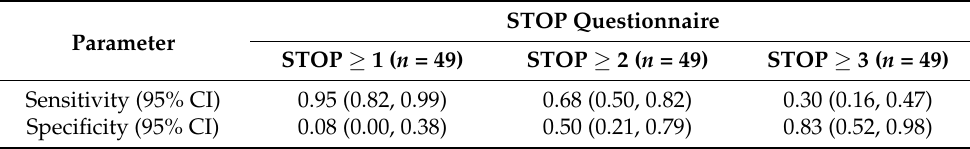
Figure 1. Questionnaire ROC Curve Analysis. Receiver operating characteristic curve for questionnaires constructed from the data presented in Tables 2 and 3. Abbreviations: ROC, receiver operating characteristic; AUC, area under the curve; BQ, Berlin Questionnaire; ESS, Epworth Sleepiness Scale; SB, STOP-BANG Questionnaire; STOP1, STOP Questionnaire using a cutoff of one; STOP2, STOP Questionnaire using a cutoff of two; STOP3, STOP Questionnaire using a cutoff of three. Table 3. Questionnaire Test Parameters for the STOP Questionnaire. The STOP Questionnaire is derived from STOP-BANG administered in Group 3, for secondary analysis. Comparison of the sensitivity and specificity of the STOP Questionnaire using a positive response for one question (STOP ≥ 1), two questions (STOP ≥ 2), and three questions (STOP ≥ 3) as cutoffs, as well as 95% CI, for the outcome of at least mild sleep disordered breathing (AHI ≥